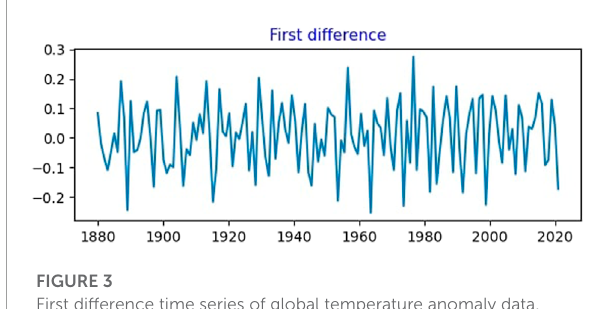
FIGURE 3 First difference time series of global temperature anomaly